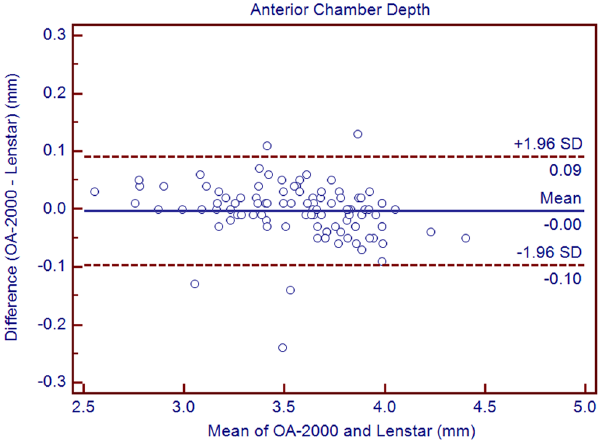
Figure 5. Bland-Altman plots show the agreement between OA-2000 swept-source optical coherence tomography and Lenstar optical low coherence reflectometry for measuring anterior chamber depth. Solid lines represent the bias between both devices and dotted lines represent the 95% confidence interval for the difference.